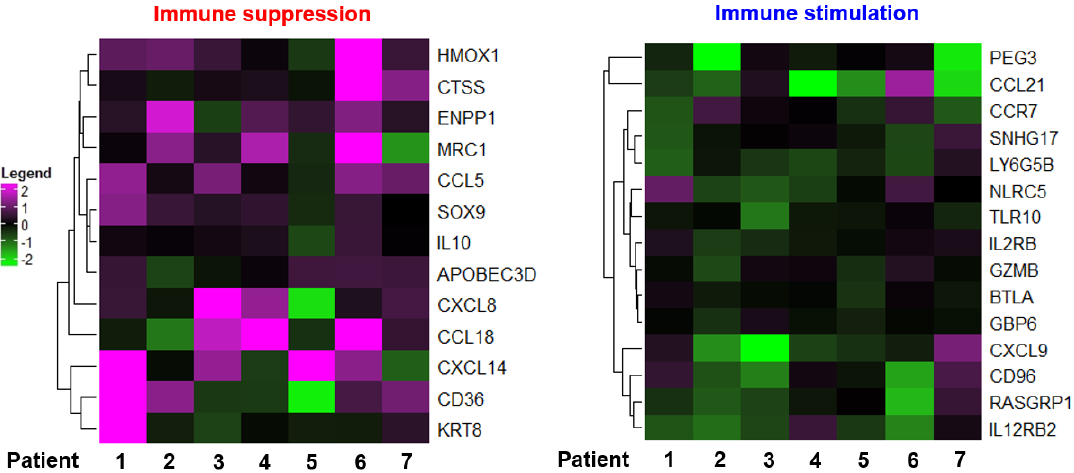
Figure 1. Heatmap of genes from breast cancer patients who underwent chemotherapeutic treatments (GSE 43816).